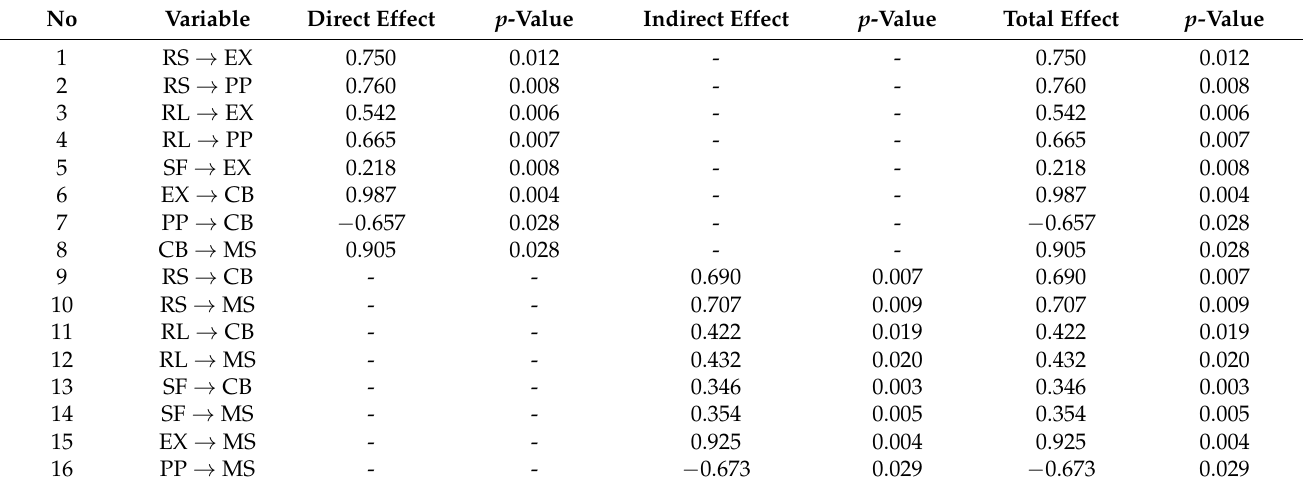
Table 7. Direct, Indirect, and Total Effects.